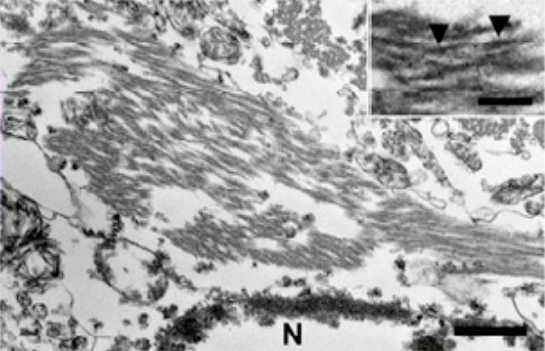
Figure 5. Neurofibrillary tangles in the cat hippocampus, transmission electron microscopy. Clusters of filaments can be found in the perikaryon in two kinds of forms: straight and paired twisted. In the case of the paired twisted form, the lengths between arrowheads were 80–100 nm. Bars=500 nm and 100 nm (inset). N stands for Nucleus. Reprinted from Acta Neuropathologica Communications , 3, Chambers J.K., Tokuda T., Uchida K., Ishii R., Tatebe H., Takahashi E., Tomiyama T., Une Y., Nakayama H. The domestic cat as a natural animal model of Alzheimer’s disease, 78, 2015, with permission from BMC [71] .